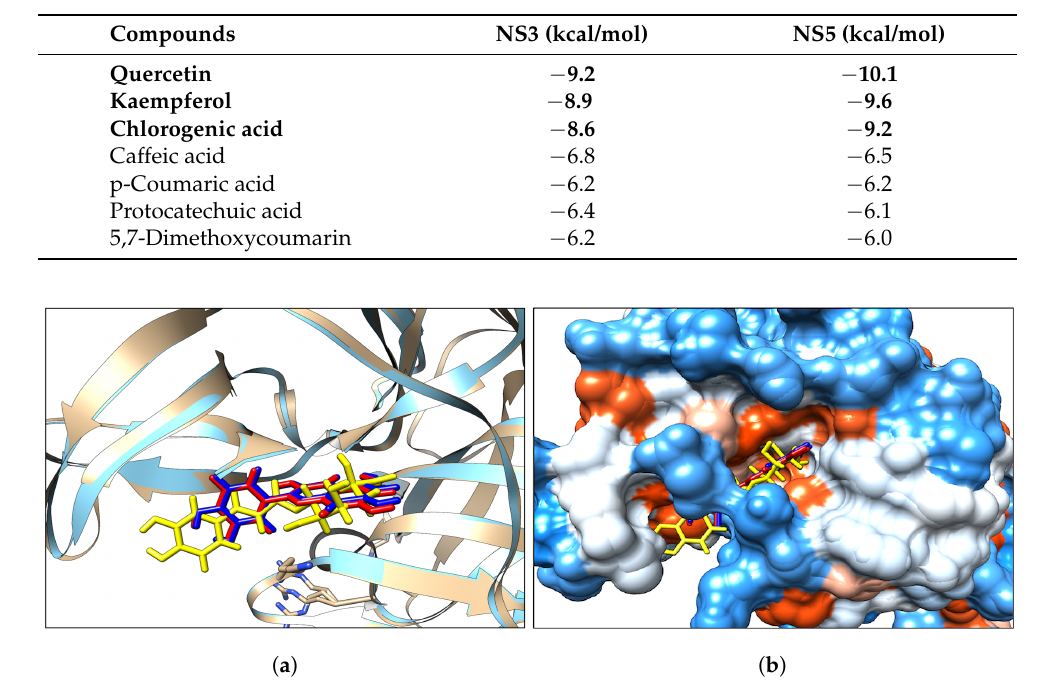
Table 1. Smina binding affinities of the seven compounds with regard to the NS3 and NS5 proteins.